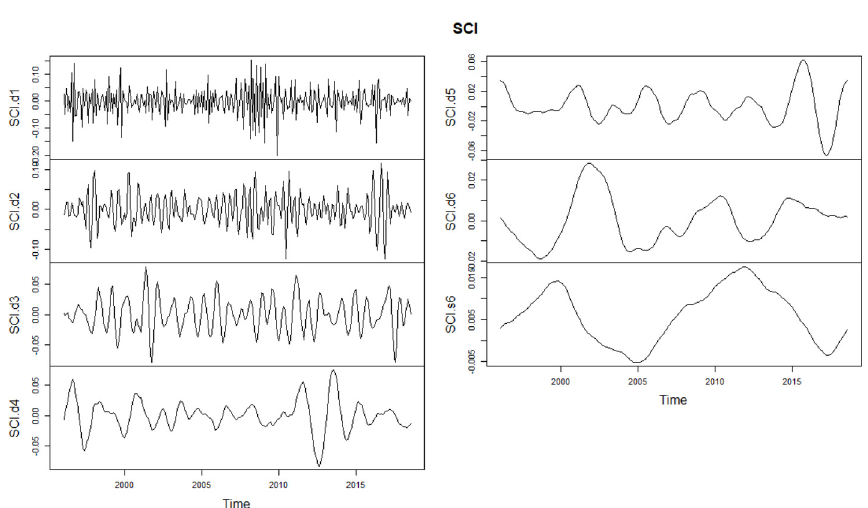
Figure 2. MODWT plot